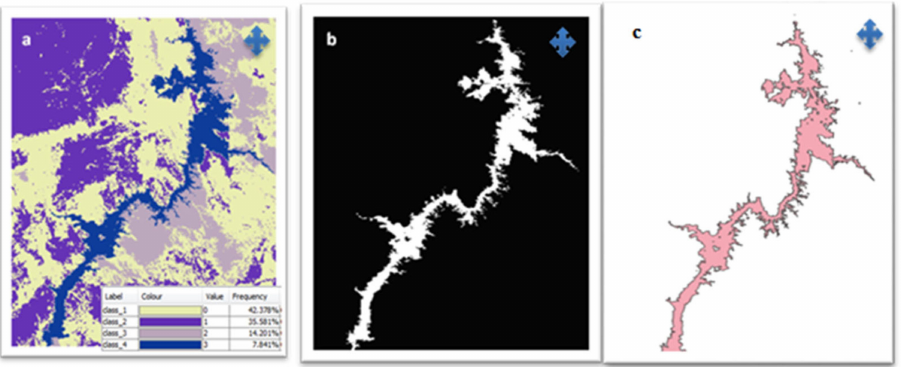
Figure 7. Processes of unsupervised k-means classification method for extract water surface of AHDL. ( a ) showed the optical image of AHDL area after applied K-means unsupervised classified with K = 4 by SNAP; ( b ) showed the land and water classes by using QGIS; ( c ) (showed the water surface of AHDL after separate land